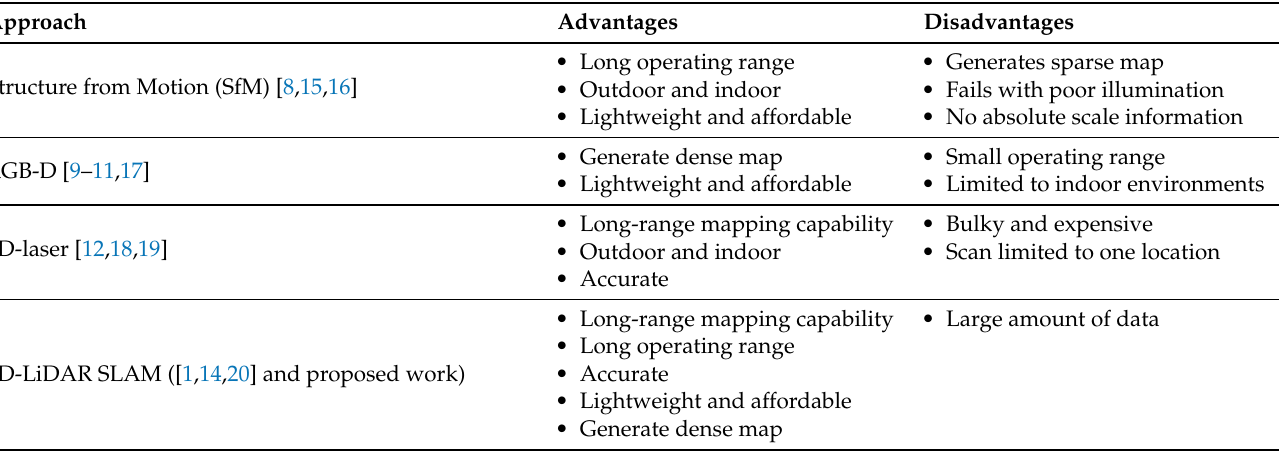
Table 1. Existing 3D radiometric mapping